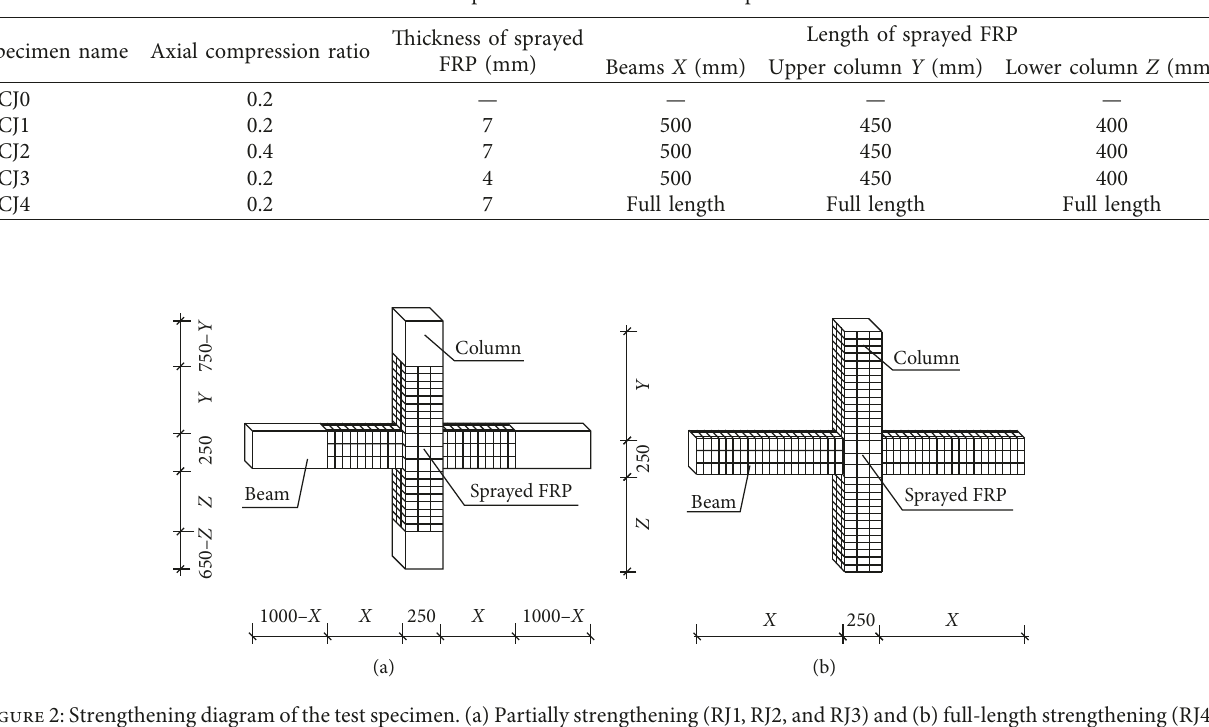
Table 1: Specific details of each tested specimen.